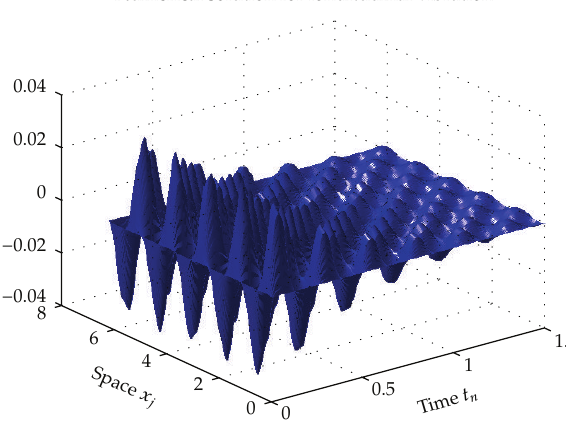
Figure 11: Total dissipation, μ (cid:8)